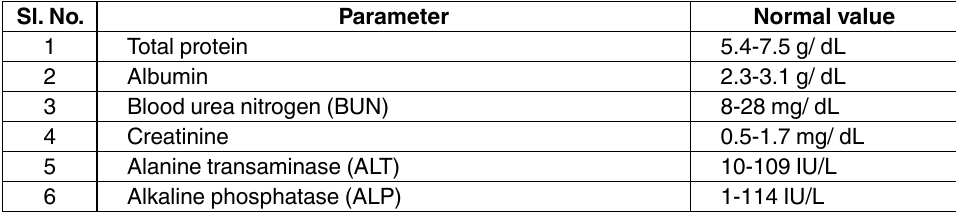
table 3. Reference range for various biochemical parameters in dogs sl. No.